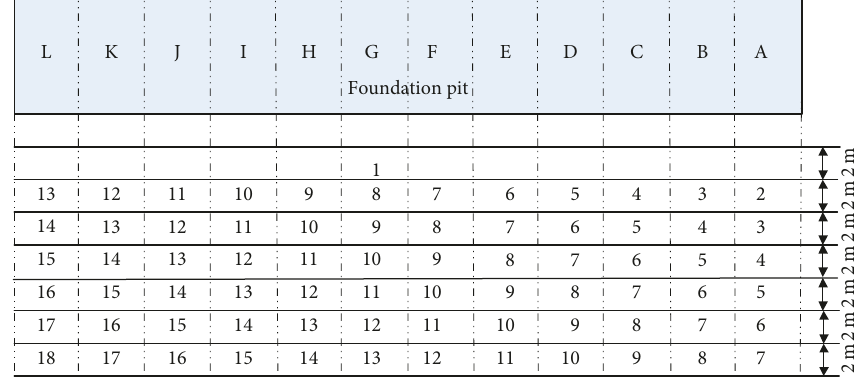
Figure 11: Second excavation mode ( W